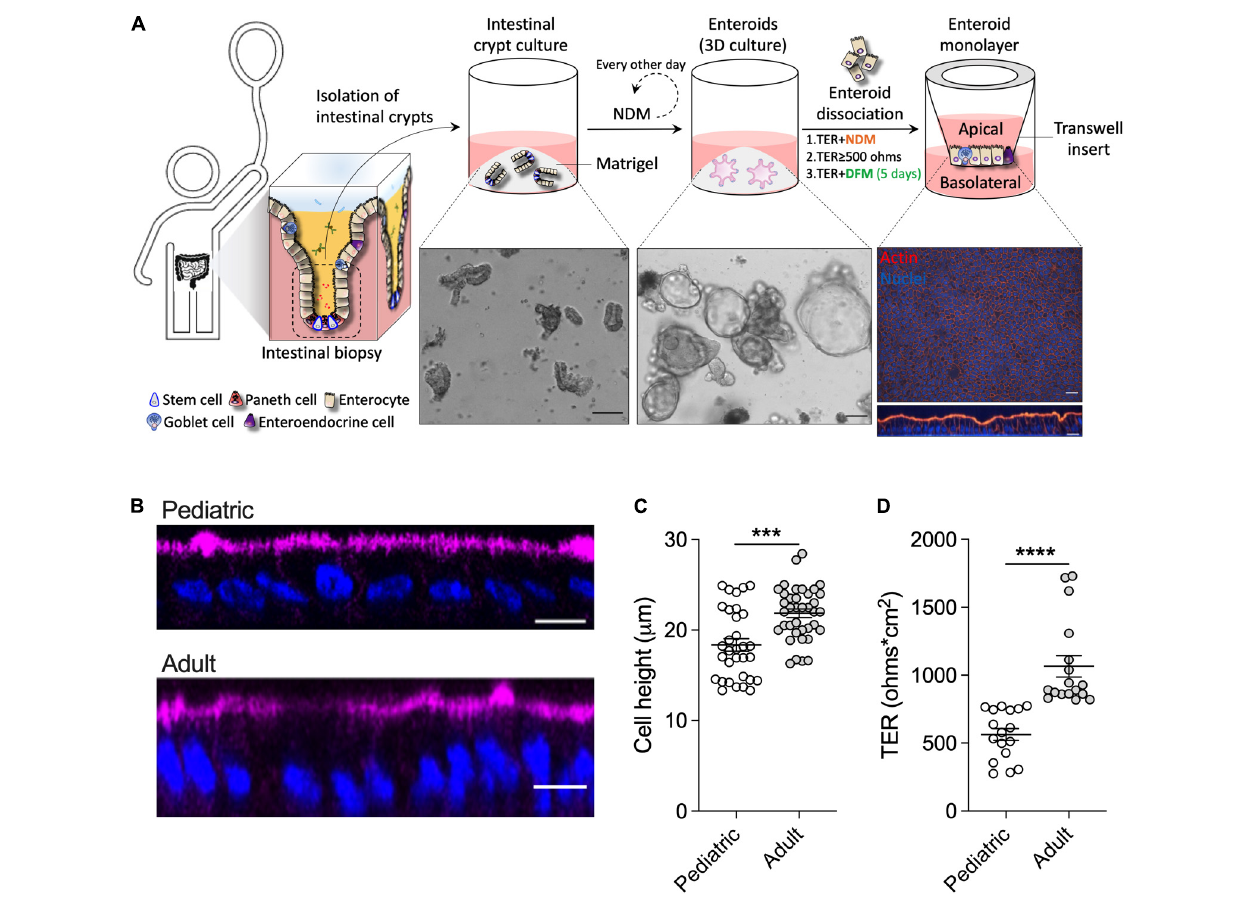
FIGURE 1 | Pediatric and adult enteroid monolayers exhibit distinct maturation features. (A) Schematic representation of the generation of pediatric enteroid monolayers. Scale bar: brightfield images, 100 µ m; immunofluorescence images (XY and XZ projections), 20 µ m. NDM, non-differentiation media; DFM, differentiation media. (B) Confocal microscopy images (XZ projections) depicting the difference in epithelial cell height between pediatric and adult enteroid monolayers. Actin, magenta; DNA, blue. Scale bar = 20 µ m. (C) Epithelial cell heights quantified by immunofluorescent confocal microscopy analysis ( ≥ 8